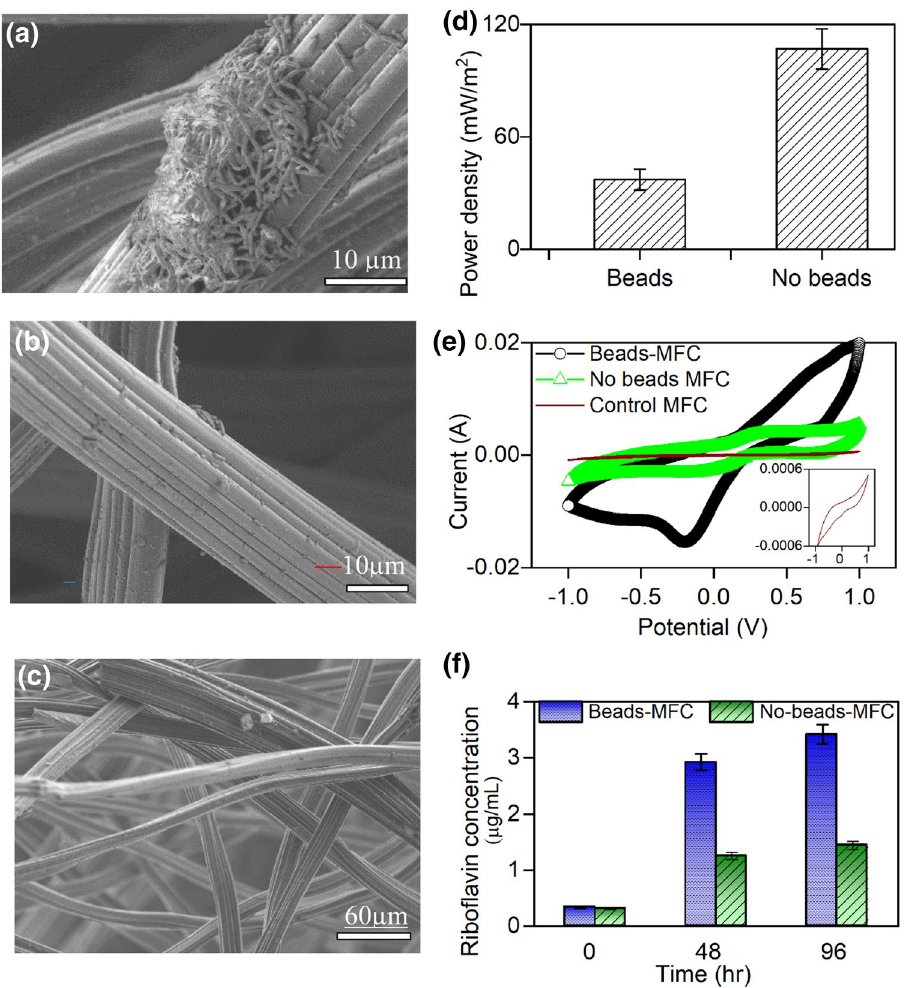
Figure 4. Microbial fuel cell beads/no beads experiment scanning electron microscopy images. ( a ) No-beads- MFC; ( b ) Beads-MFC; ( c ) Control-MFC; ( d ) Representative Power density; ( e ) Cyclic voltammetry (Inset shows voltammogram shape of control-MFC); ( f ) HPLC data showing riboflavin